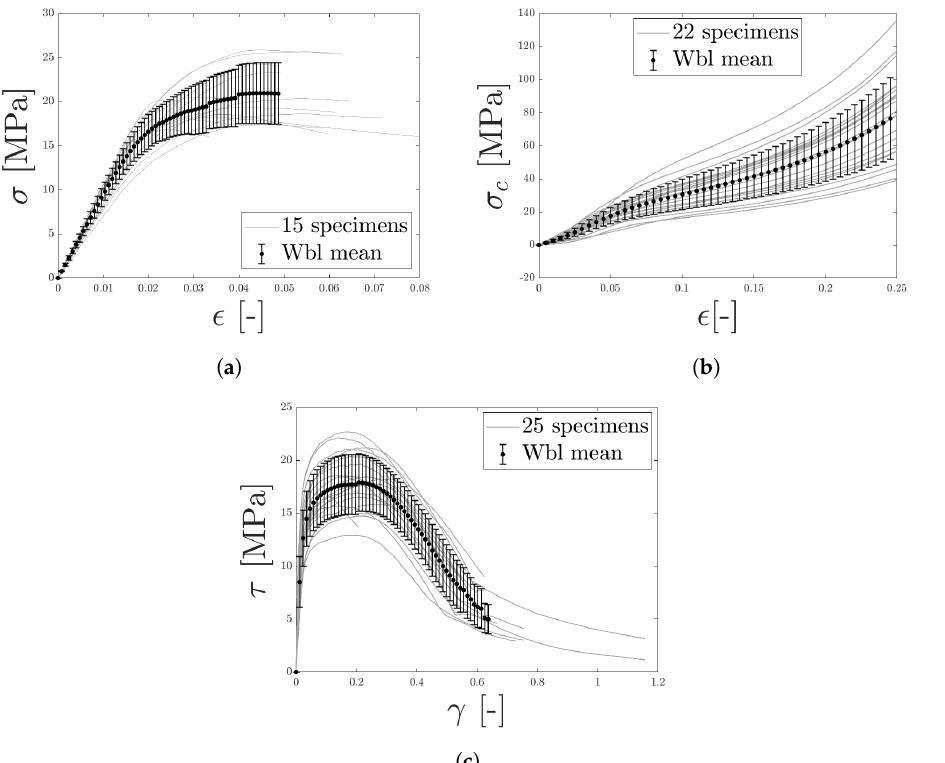
Figure 24. For LCs 1–3, a Weibull mean curve was computed and the standard deviation indicated. In ( a , b ), the transverse stress–strain response of tensions and compression are presented, respectively, whereas ( c ) contains the response from out–of–plane